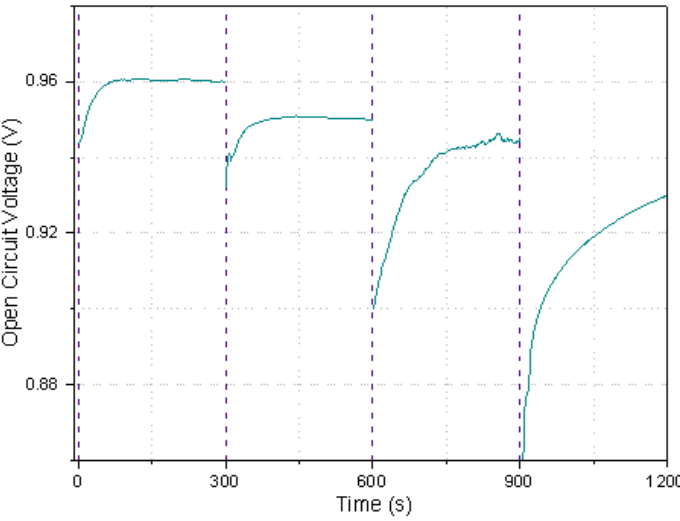
Figure 5. Open circuit voltage stability, using urine as fuel for an air-breathing paper-based µFC with TiO 2/ Ni anode and Pt/C cathode inside the qualitative pregnancy